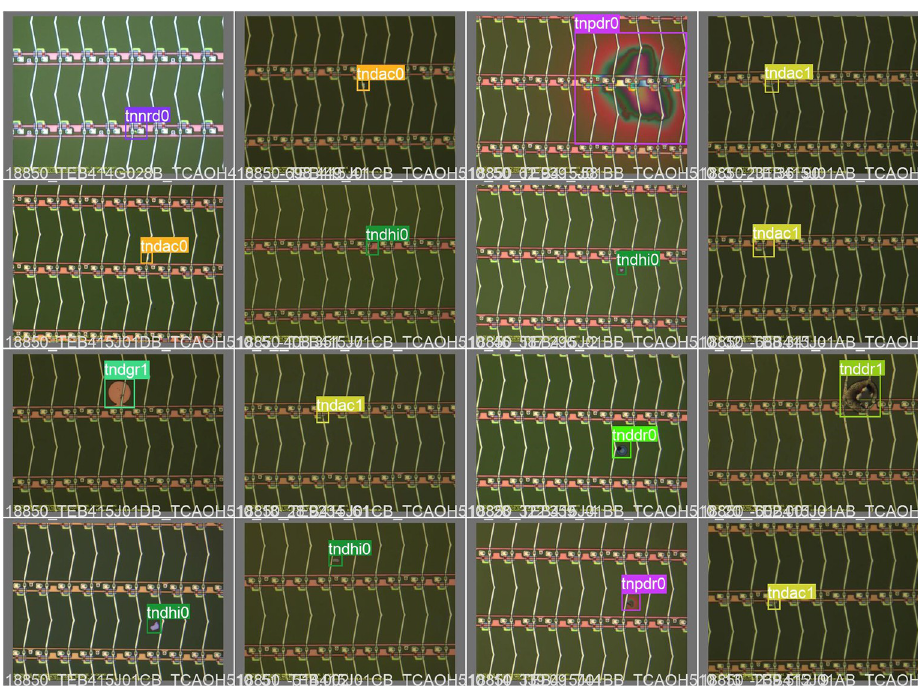
Fig 1. Common electronic panel surface